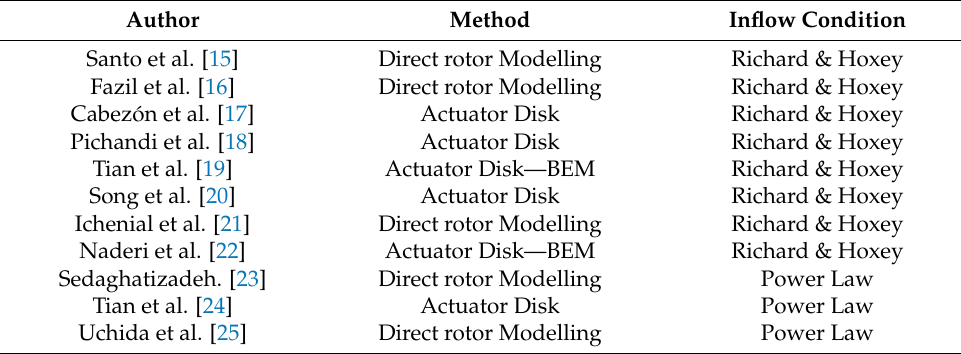
Table 1. A summary of atmospheric boundary layer modelling